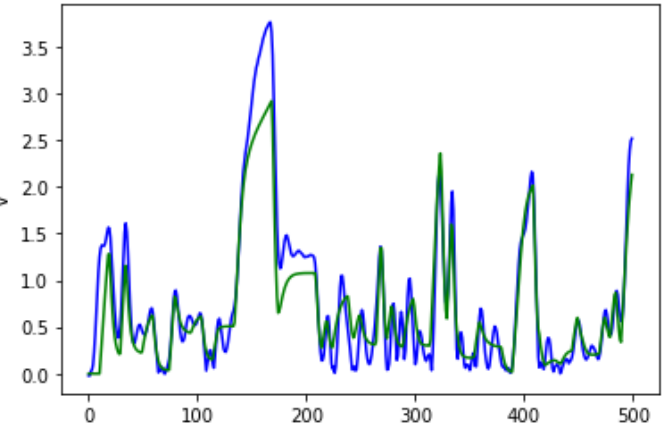
Figure 14. Output from simulation (green) using the best found individual for the Coupled Drives problem, compared to the empirical data